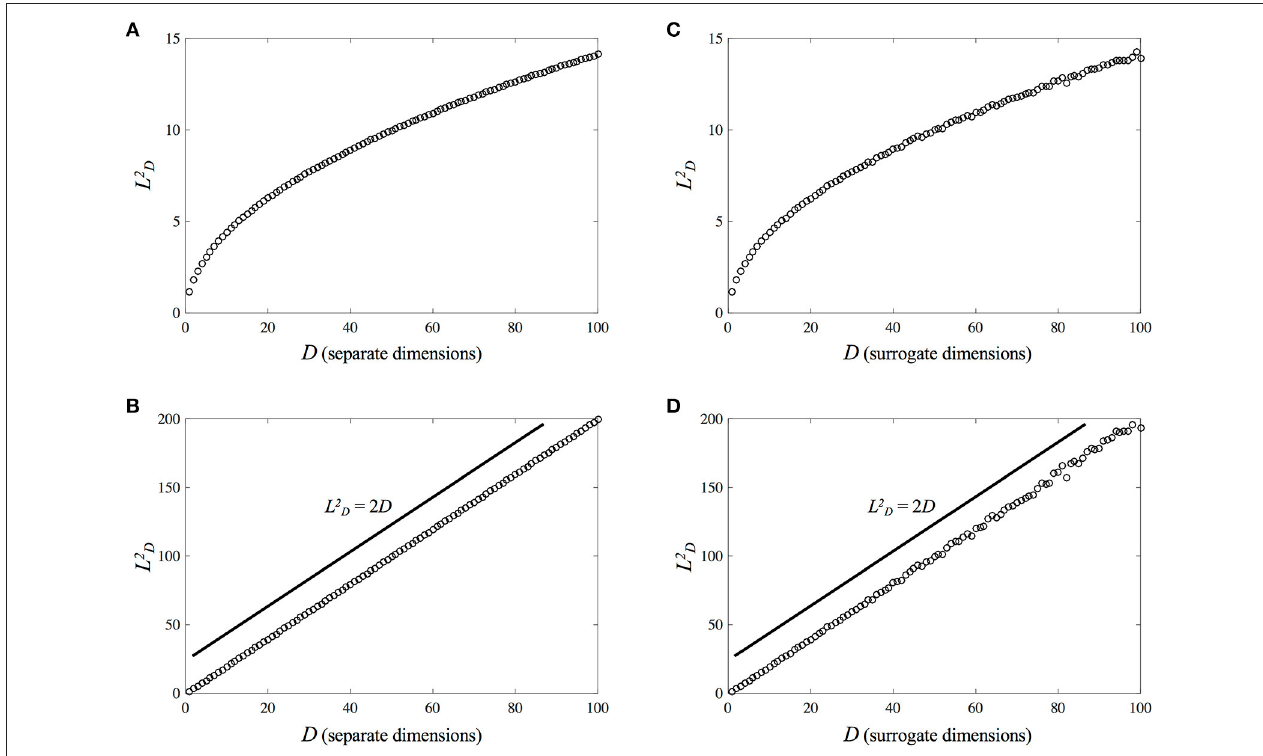
FIGURE 8 | Scaling of average phase-space distance with phase-space dimensionality (each dimension is a z -scored random variable taken from a uniform distribution [0, 1]). (A) Shows the increase of average distance as a function of separately added dimensions, and (B) shows that the increase in average distance follows the square-root of the dimensionality of the phase-space. (C) Shows the increase of average distance as a function of separately number of embeddings via time-delayed surrogates of a single random variable, and (D) shows that the increase in average distance follows the square-root of phase-space 1 / 2 dimensionality as well. Distances in both cases scale similarly, with L D = (cid:16) L 2 D + n − 2 n (cid:17) .